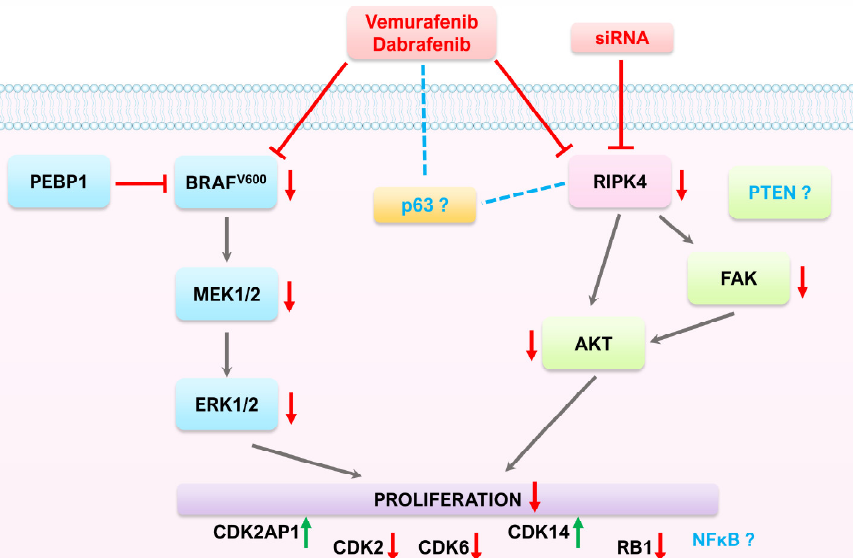
Figure 10. Proposed mechanisms of action of BRAFi (vemurafenib, dabrafenib) and RIPK4 on the RAF1/MEK/ERK pathway and proliferation in melanoma cells with BRAF V600 . Supplementary Materials: The following supporting information can be downloaded at: www.mdpi.com/xxx/s1, Figure S1: identification of the mutated variant of the BRAF gene; Figure S2: comparison of full-length of amino acid sequences of human RIPK4 (Sbjct) and BRAF (Query) using BLAST. Table S1: antibodies used for Western Blot and immunofluorescence analyses; Table S2: List of TaqMan probe used and purchased from Thermo Fisher Scientific/Invitrogen. The raw data file.